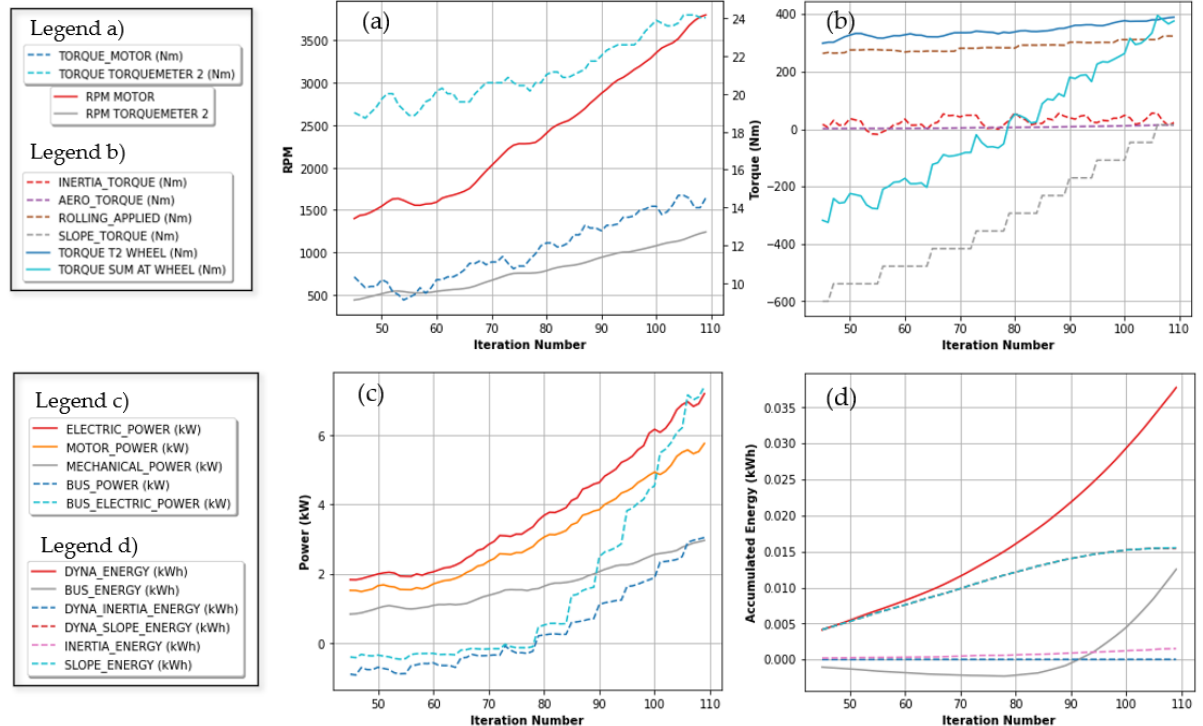
Figure 14. Downhill section with changing slope. ( a ) Torques and RPMs measured by dynamometer sensors. ( b ) Torques values per origin force. ( c ) Dynamometer power and equivalent bus power. ( d ) Accumulated energy for the whole route.